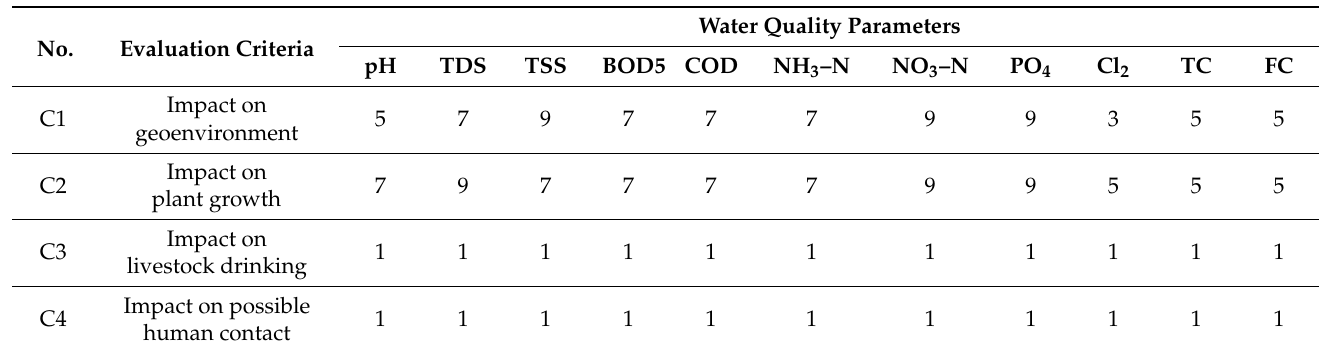
Table A1. Decision matrix for scenario 1 (restricted irrigation).